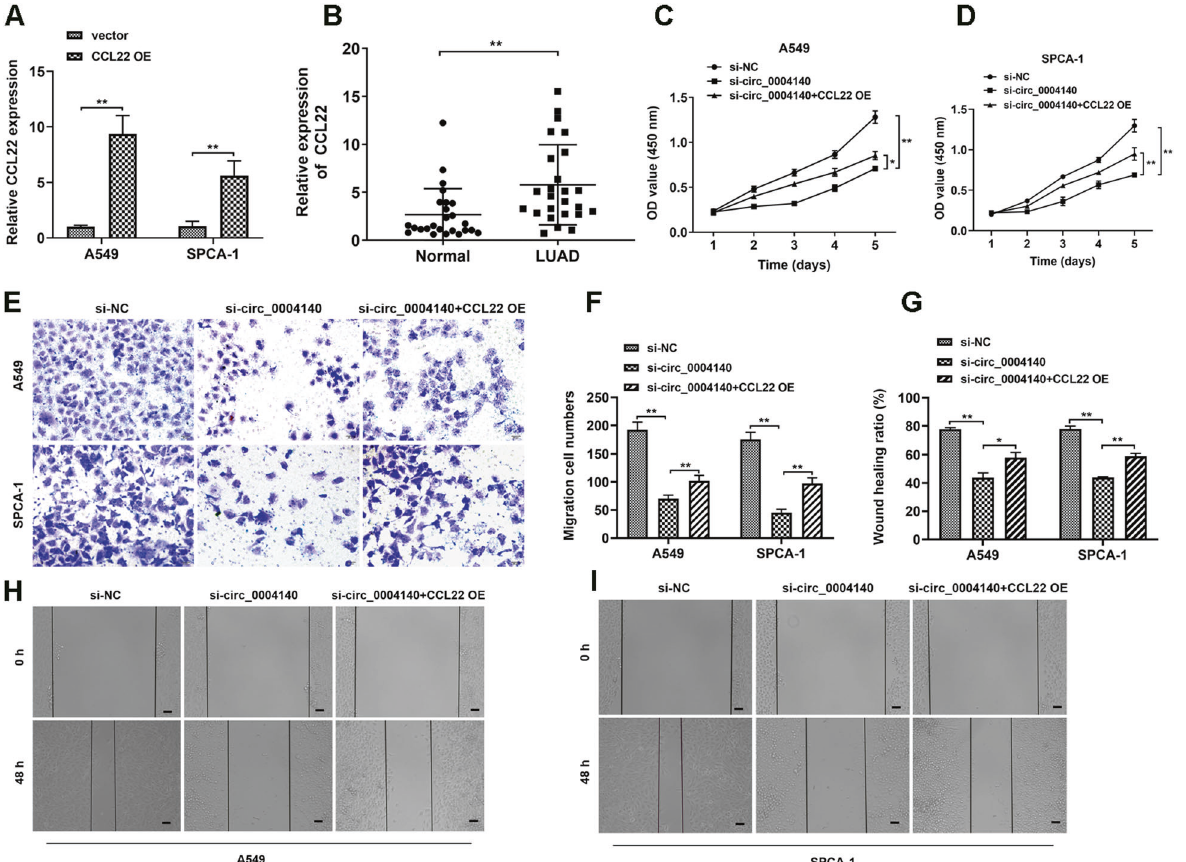
Fig. 5 Elevated CCL22 reverses circ_0004140 knockdown-induced biological functions. A The overexpression ef fi ciency was detected via RT-PCR analysis in A549 and SPCA-1 cells after transfection with CCL22 overexpression plasmid or blank vector ( n = 3). B RT-PCR analysis was used to examine the CCL22 expression in 25 paired LUAD clinical samples. C , D The cell viability of A549 ( C ) and SPCA-1 ( D ) cells was determined by CCK-8 assay after co-transfection with si-circ_0004140 and CCL22 overexpression plasmids ( n = 3). E , F Rescue